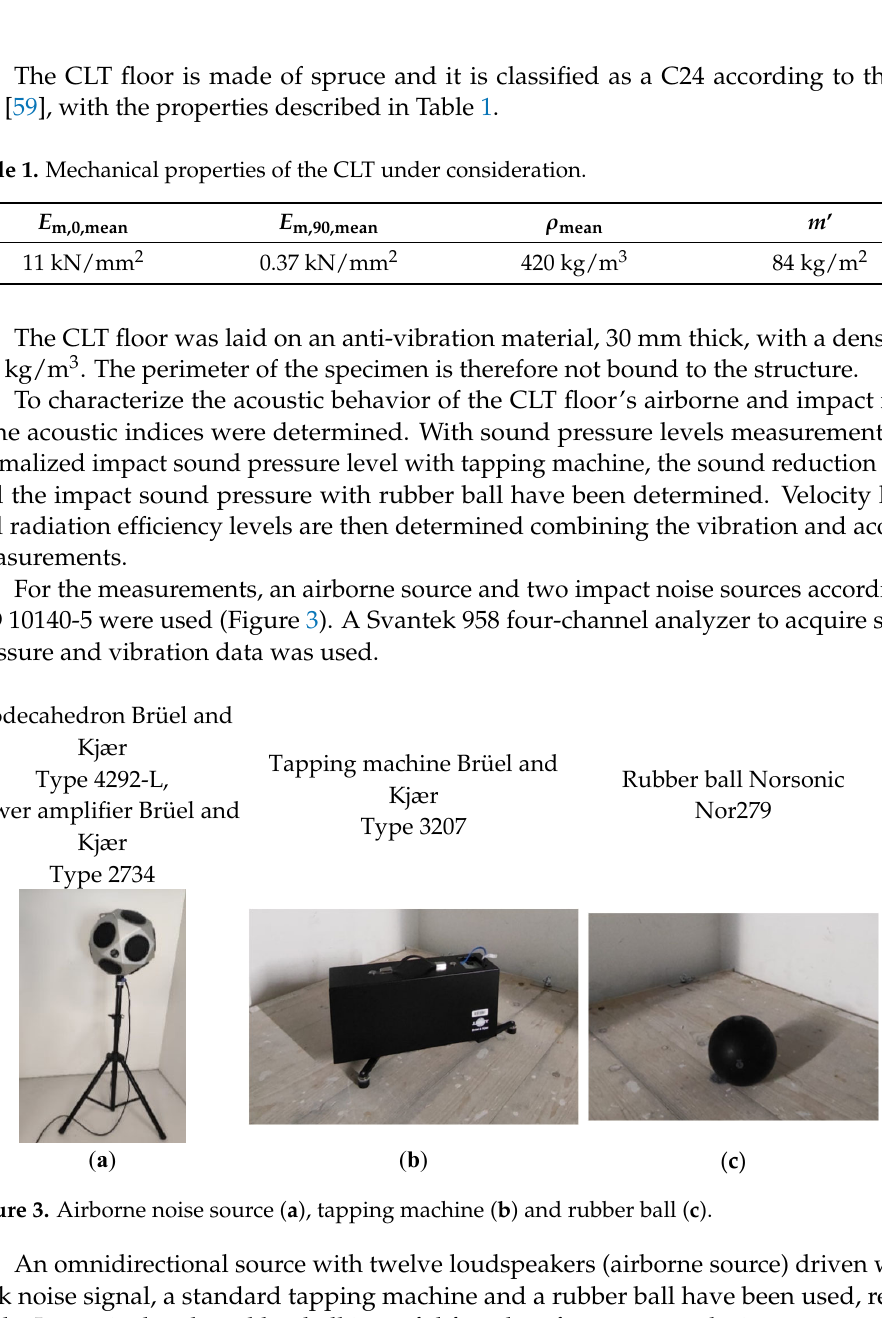
Figure 2. Wood fiber direction. Longer dimension (4155 mm) with 2 resistant layers ( a ). Shorter